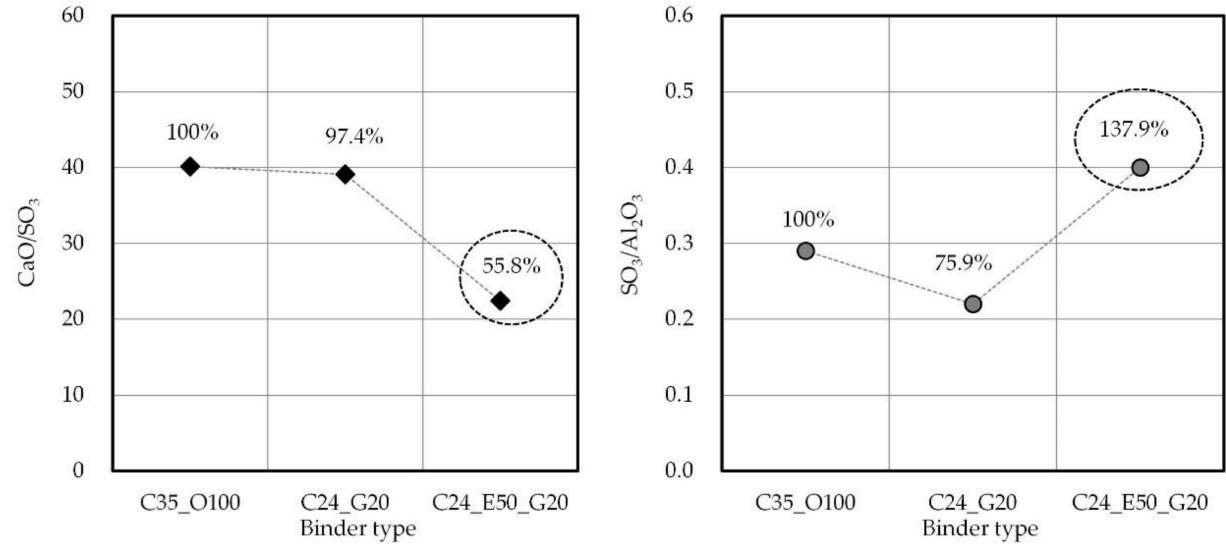
Figure 6. CaO/SO 3 and SO 3 /Al 2 O 3 ratios in binder type.